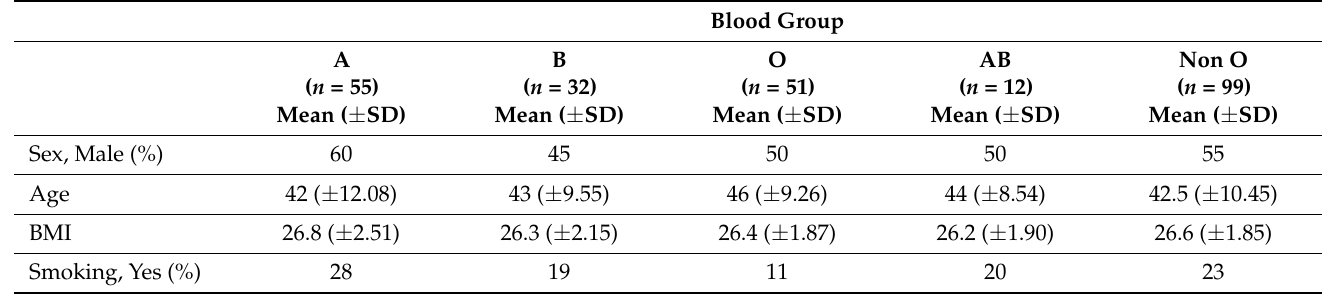
Table 1. Baseline characteristics of all study participants ( n = 150) according to ABO blood system. Blood